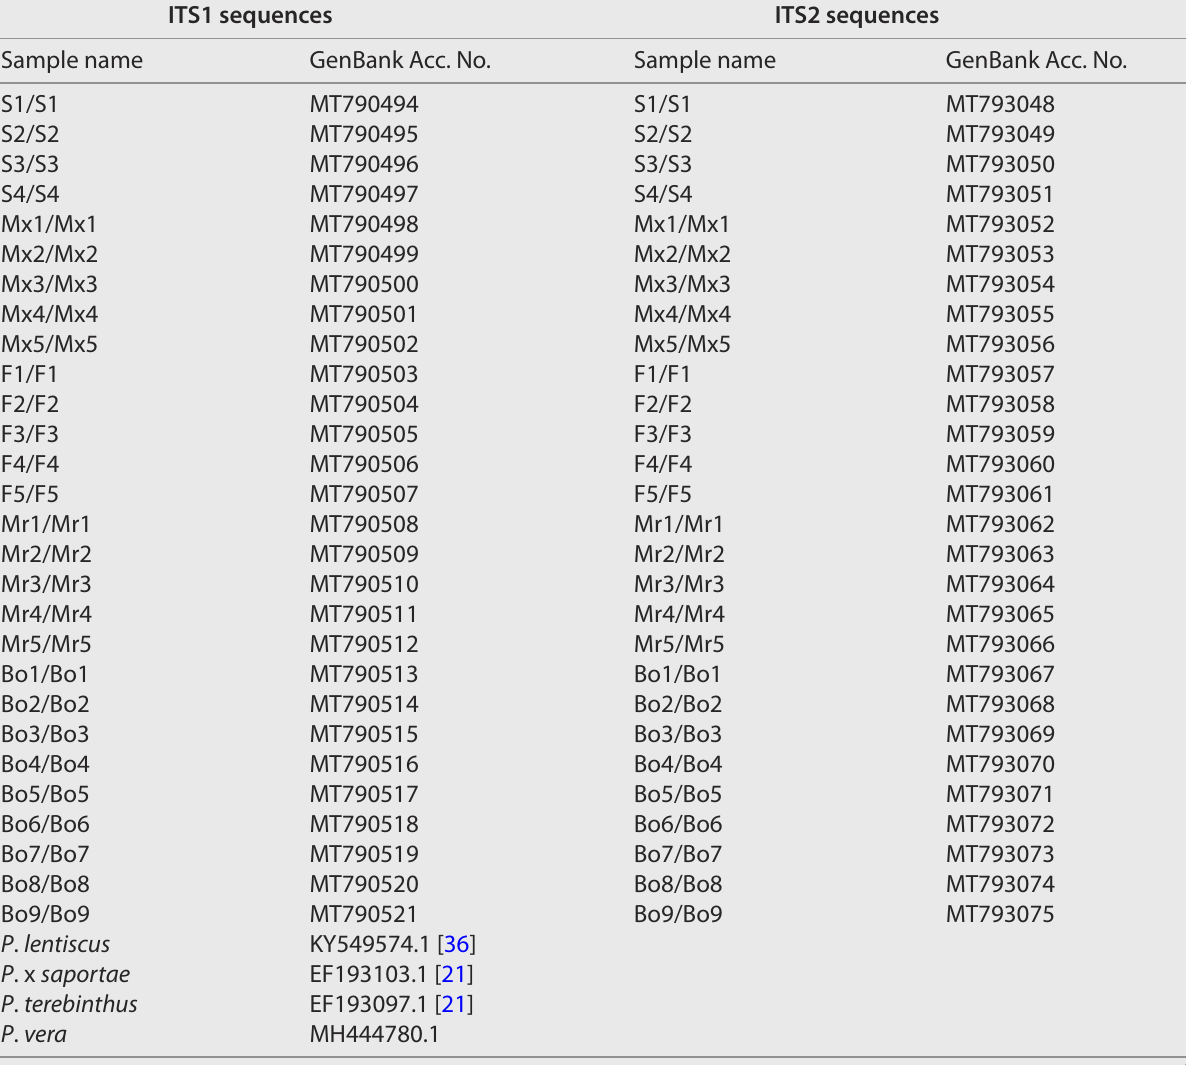
Table 3 List of accession numbers of deposited sequences and the sequences of reference plants used in this study ITS1